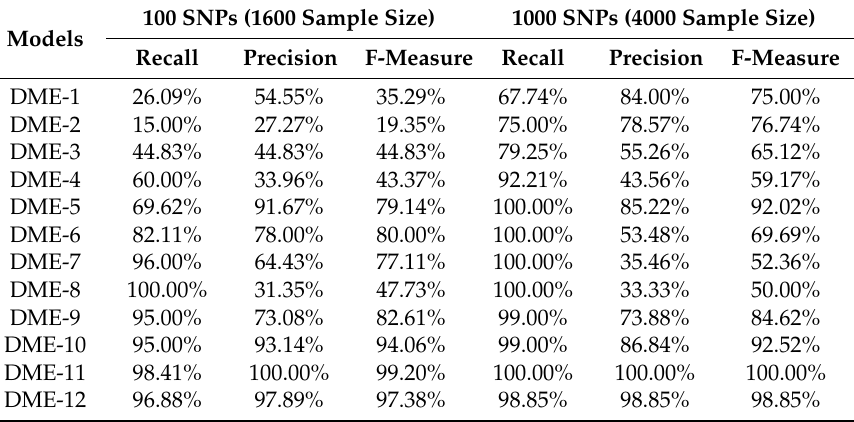
Table 1. The recall, precision, and F-measure of FDHE-IW using 12 disease loci with marginal effects (DME) models.